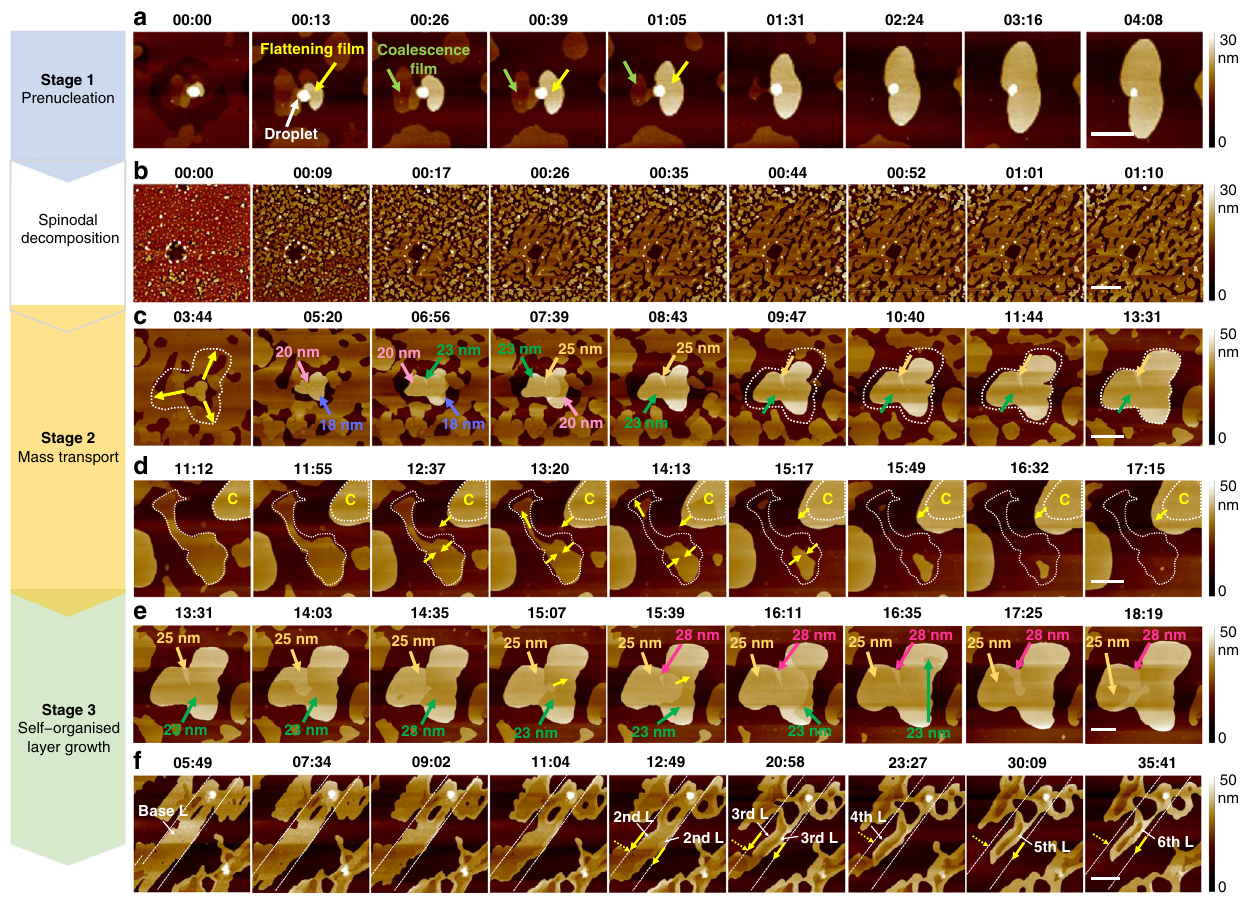
Fig. 2 Time-resolved fi lm self-growth kinetics at different stages. a Flattening of liquid-like droplet into pancake-like fi lms. Scale bar: 2 µ m. b Spinodal decomposition. Scale bar: 5 µ m. c Ostwald ripening of a thick fi lm to grow laterally. Scale bar: 2 µ m. d Disappearance of a thin fi lm. Scale bar: 2 µ m. e Layer and lateral growth occurring simultaneously. Scale bar: 2 µ m. f Self-organised layer growth: lateral self-etching for layer growth. Scale bar: 2.5 µ m. (35:41 means growth time t = 35 h 41 10 min. The bicontinuous surface pattern for the early dewetting volume thin fi lms to small-volume thick ones (Sample 1: stage appears super fi cially similar to spinodal decomposition Supplementary Figs. 20 and 21; Sample 2: Supplementary Figs. tions. The fi lm eventually demixed into meta-stable thin fi lms and stable thick fi lms, along with the satellite hole ing thin- fi lm dewetting on solid substrates (Supplementary Figs.